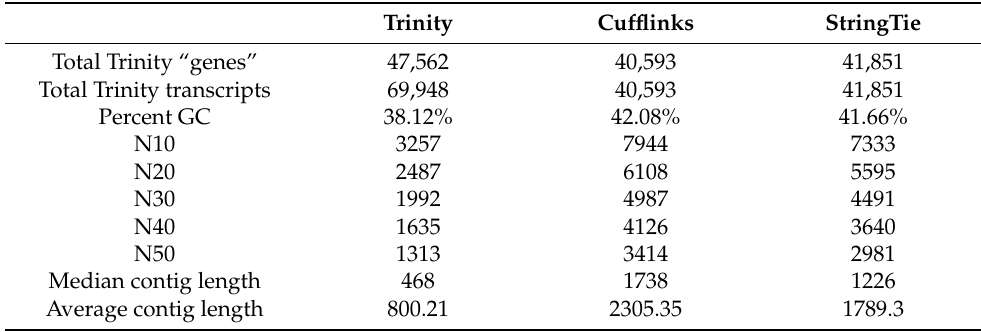
Table 4. Contig statistics of the different transcriptome assemblies from Bombyx mori strains. Statistics generated from